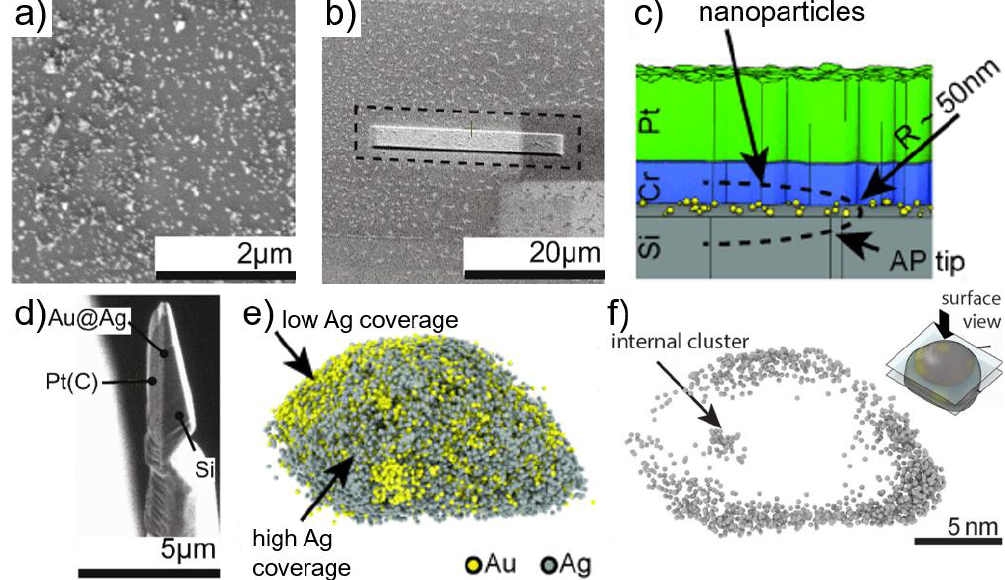
Figure 8. Investigation of Au@Ag nanoparticles prepared by the embedding method. ( a ) Dispersion of nanoparticles on Si substrate; ( b ) same sample after coating with Cr and Pt(C) strip; ( c ) schematic representation of the embedding method; ( d ) tip-sample after lift-out and before FIB milling: Au@Ag nanoparticles are sandwiched between the two solid layers; ( e ) atom map of a single nanoparticle highlighting the heterogeneous Ag surface coverage; and ( f ) 2 nm slice through the reconstruction showing the presence of an internal cluster. Panels ( a , b , d ): reprinted from [123], Copyright (2015), with permission from Elsevier. Panels ( c , e – f ): reproduced from [124]. Copyright (2014), John Wiley & Sons, Ltd.